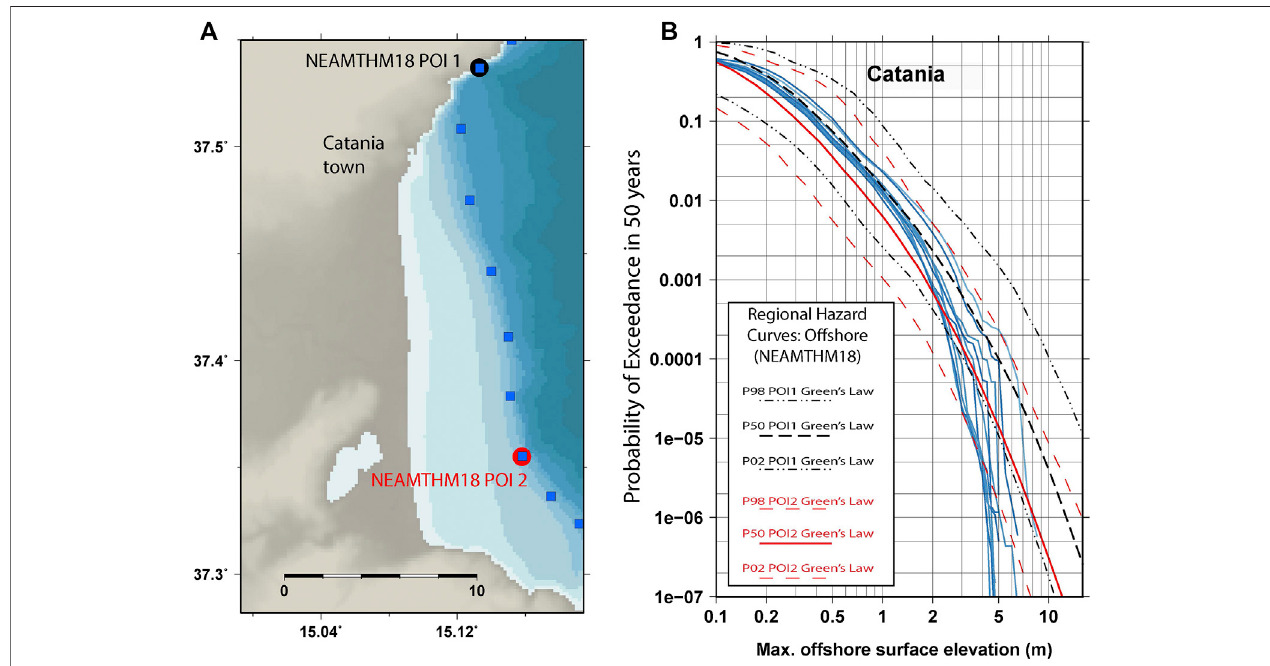
FIGURE5 | Locationsof PoIs offshore Catania (A) from thecurrentstudy (bluesquares,with2 km spacing) and NEAMTHM18(the red and black circles only, with 20 kmspacing).ComparisonofProbabilityofExceedancecurves (B) forthePoIsindicatedonthemap.Thebluelinesinpanel (B) aretheaggregatedhazardcurvesfrom the new simulations at each of the PoIs marked with blue squares in panel (A) . The red and black curves in panel (B) are offshore PoE derived from the corresponding NEAMTHM18 hazard curves with the offshore height calculated from the MIH using Green ’ s Law. The PoIs labeled POI1 (black) and POI2 (red) have geographical coordinates 37.537 o N 15.133 o E and 37.355 o N 15.158 o E